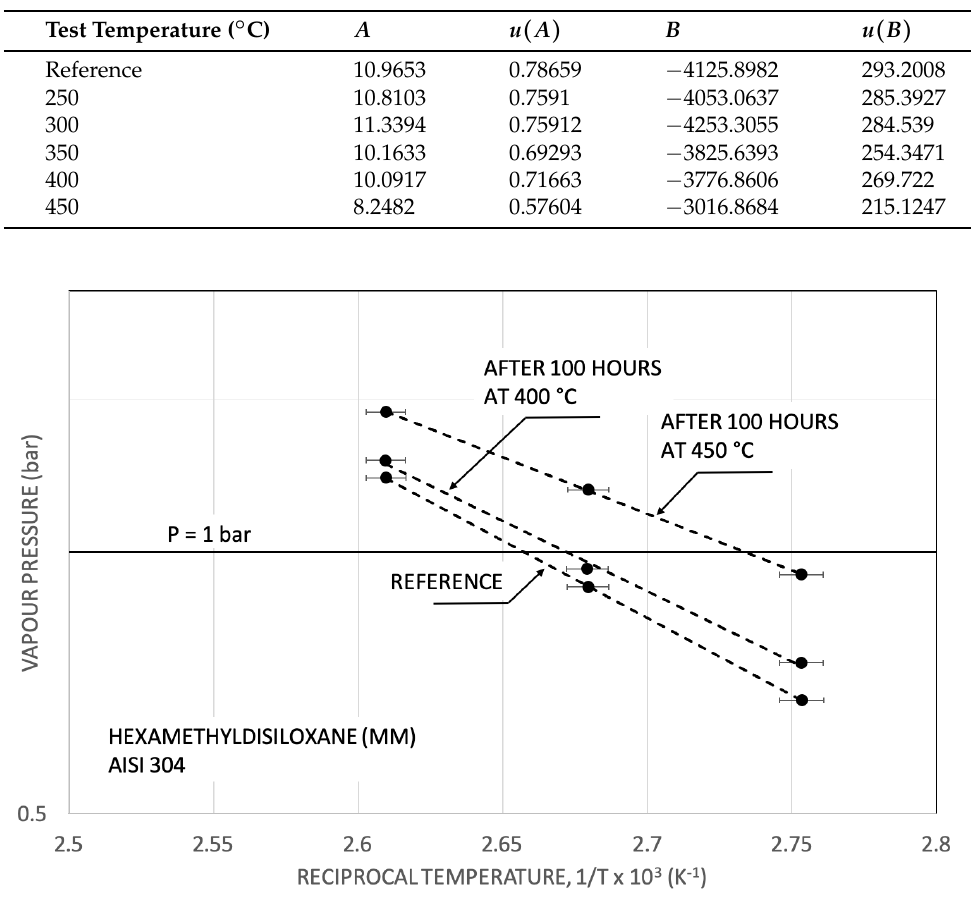
Table 2. Coefficients A and B of Equation (1) after the keeping of the sample of MM at different test temperatures, each time for one hundred hours.